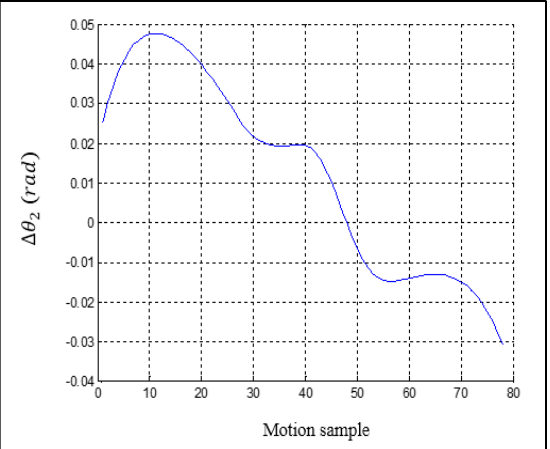
Fig. 17. The change in first and second angles of the two-link robot arm result for the D* based on PSO path for the second environment.